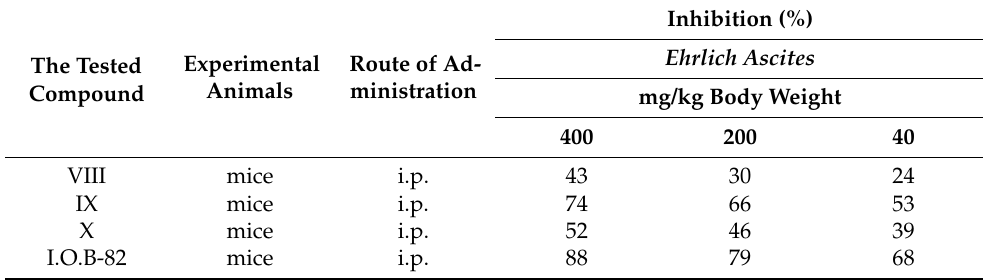
Table 9. Inhibition (%) of N mustards